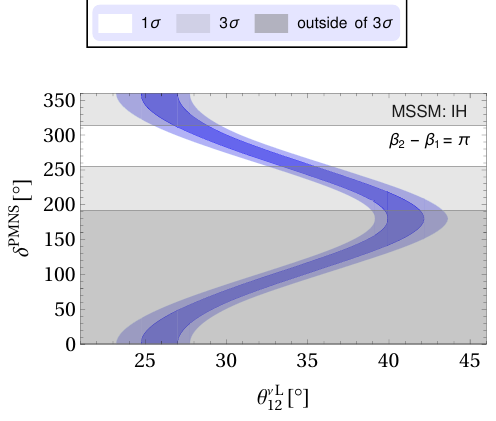
Figure 4 . Predictions for the 1 σ and 2 σ HPD intervals of the PMNS Dirac CP phase δ PMNS as a function of θ ν including running effects for the MSSM case IH and a Majorana phase 12 difference β = π . The experimental 1 σ and 3 σ ranges are represented by white and light gray 1 − β 2 regions,